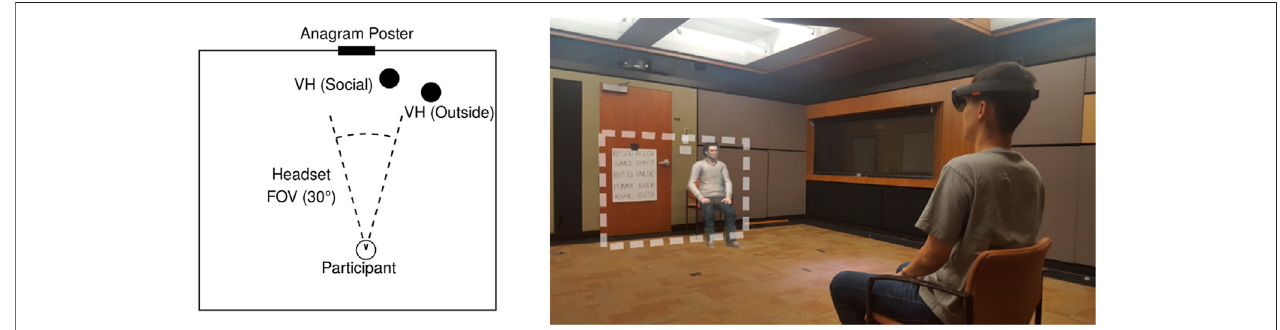
FIGURE 3 | The left panel is a bird ’ s-eye diagram of the study setup. The right panel is a photo of the campus-based study location, with the researcher posing in the place of a participant. The white dotted area indicates the user ’ s virtual FOV.